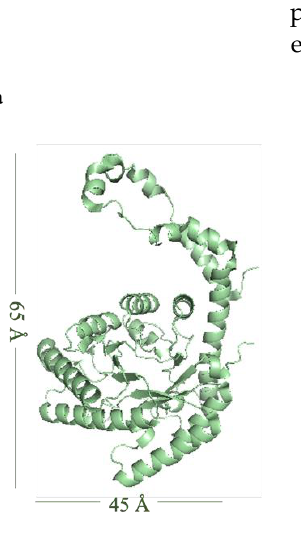
Figure 1. ( a ) The structure of monomeric glucose isomerase from Streptomyces rubiginosus (PDB: 4ZB2) [45]. ( b ) The Pdx1 – Pdx2 complex from the homologue Bacillus subtilis (PDB: 2NV2) shown in two orientations rotated by 90°. Twelve Pdx1 synthase subunits form a double hexameric ring core (purple), to which twelve Pdx2 glutaminase subunits (orange) are attached [44].